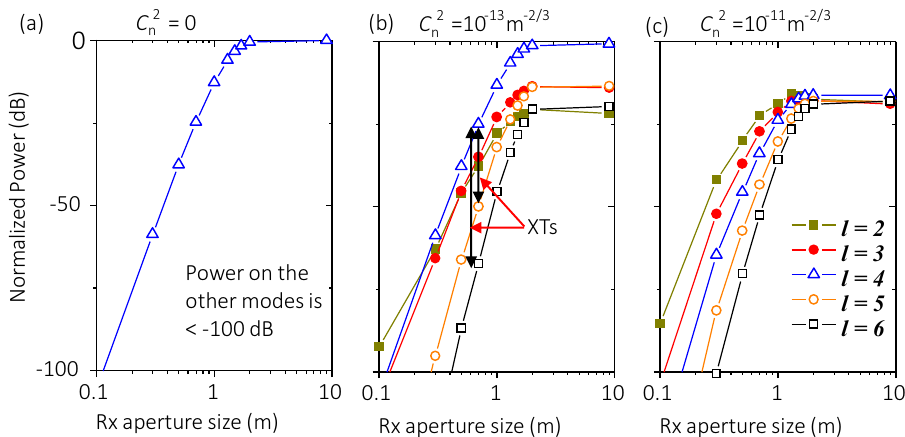
Figure 9. Effects of varying the aperture size on normalized power distribution on different OAM modes. 2 C 2 C 2 100-m links with ( a ) C n = 0 m −2/3 , ( b ) n = 1 × 10 –13 m −2/3 , and ( c ) n = 1 × 10 –11 m −2/3 . Other parameters are set as w 0 = 1 m, f = 5 THz, and OAM + 4 is transmitted. Legends and scales in y -axis in ( a – c ) are the same. XT crosstalk.